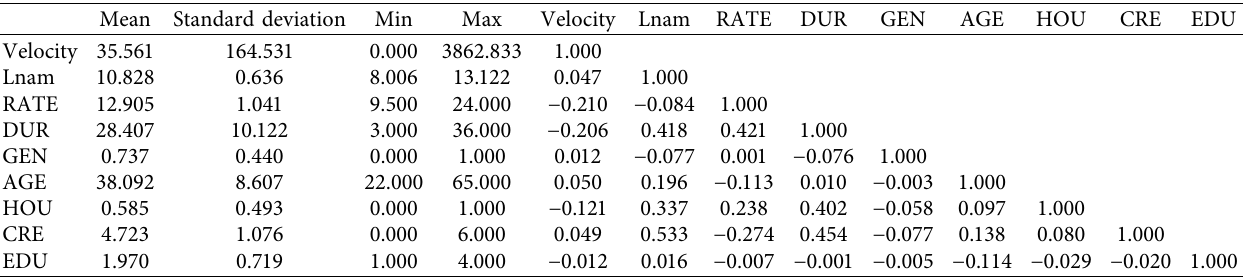
Table 5: Descriptive statistics and correlation tests for hypothesis 3.